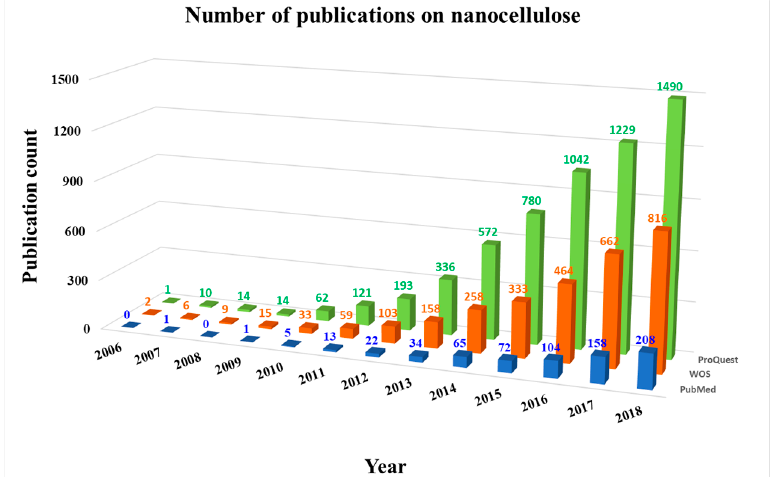
Figure 1. The number of publications on nanocellulose found in three databases: ProQuest (green), Web of Science (WOS, red), and PubMed (blue) from 2006 to 2018 using the search term “nanocellulose.”